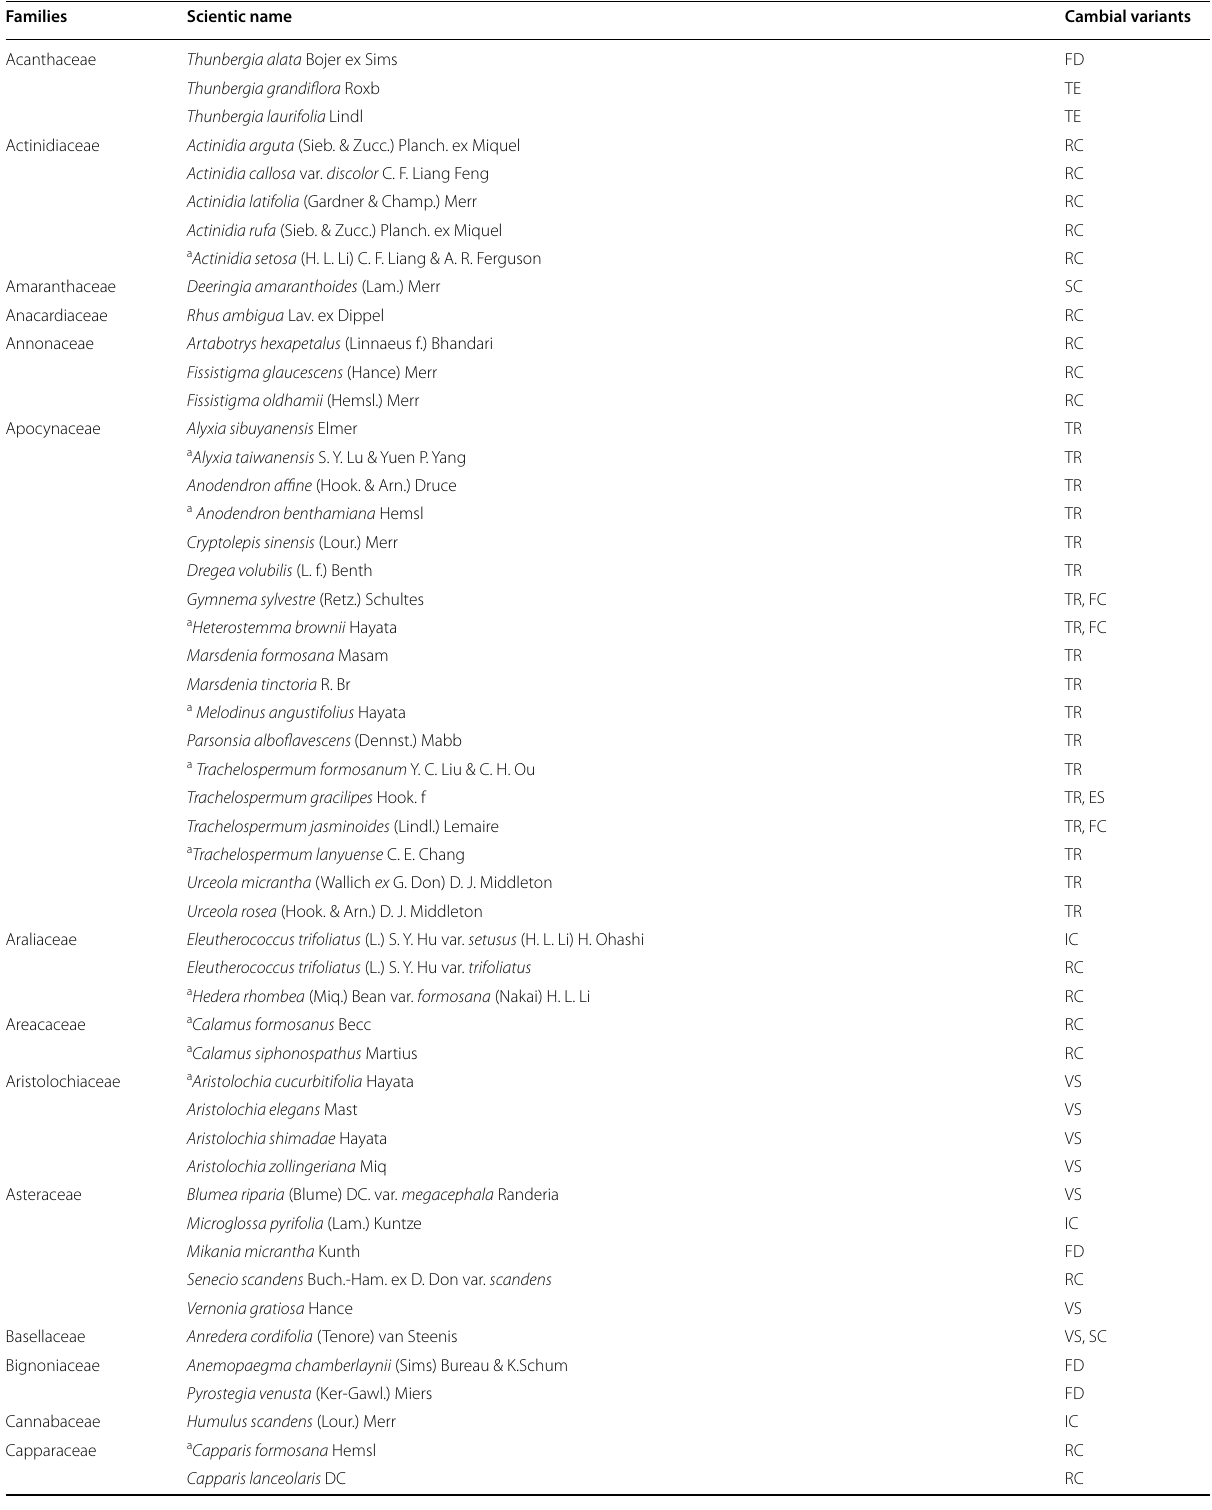
Table 1 Cambial variants of each species in Taiwan lianas